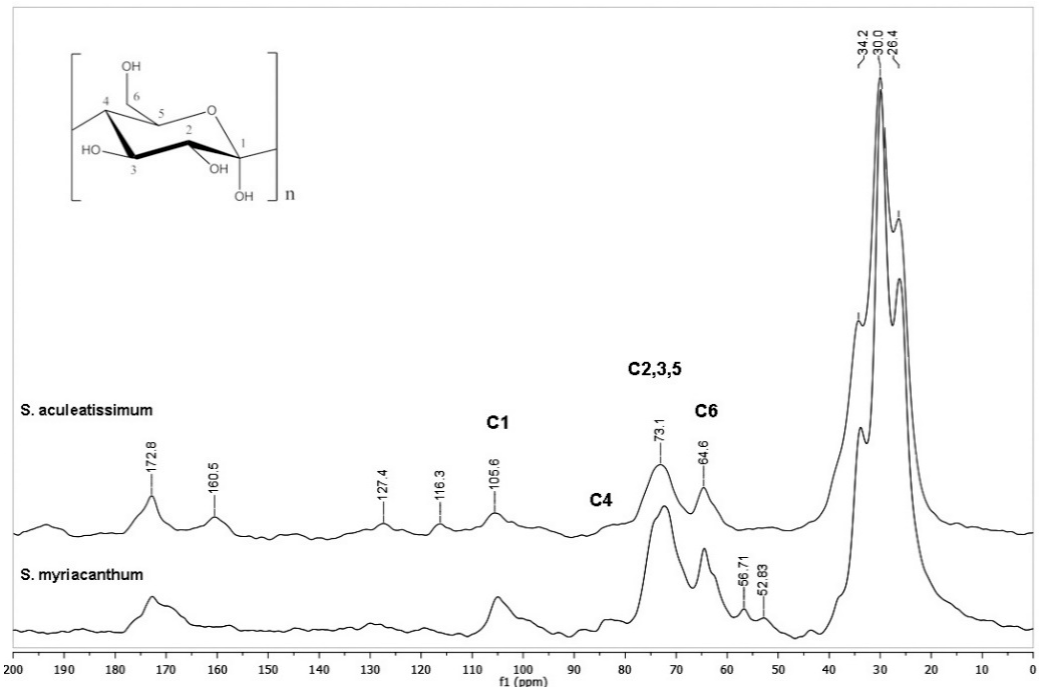
Figure 2. CPMAS 13 C NMR spectra of cutins from S. aculeatissimum and S. myriacanthum .